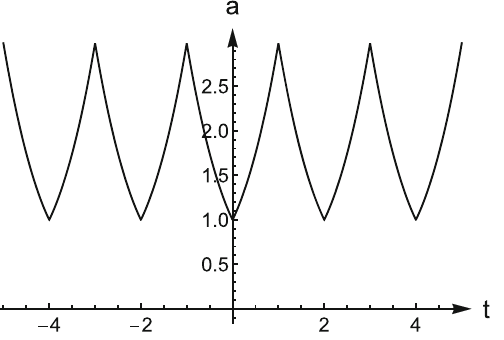
Fig. 2 The left plot shows bounce universes, where ˙ a reverses its sign at t = 0, a 0 = 1.Wehavechosen λ = 1and w = − 1 , − 2 / 3 , − 1 / 3 , 1 / 3 for the lines from the top to the bottom. The right plot is the cosmolog-